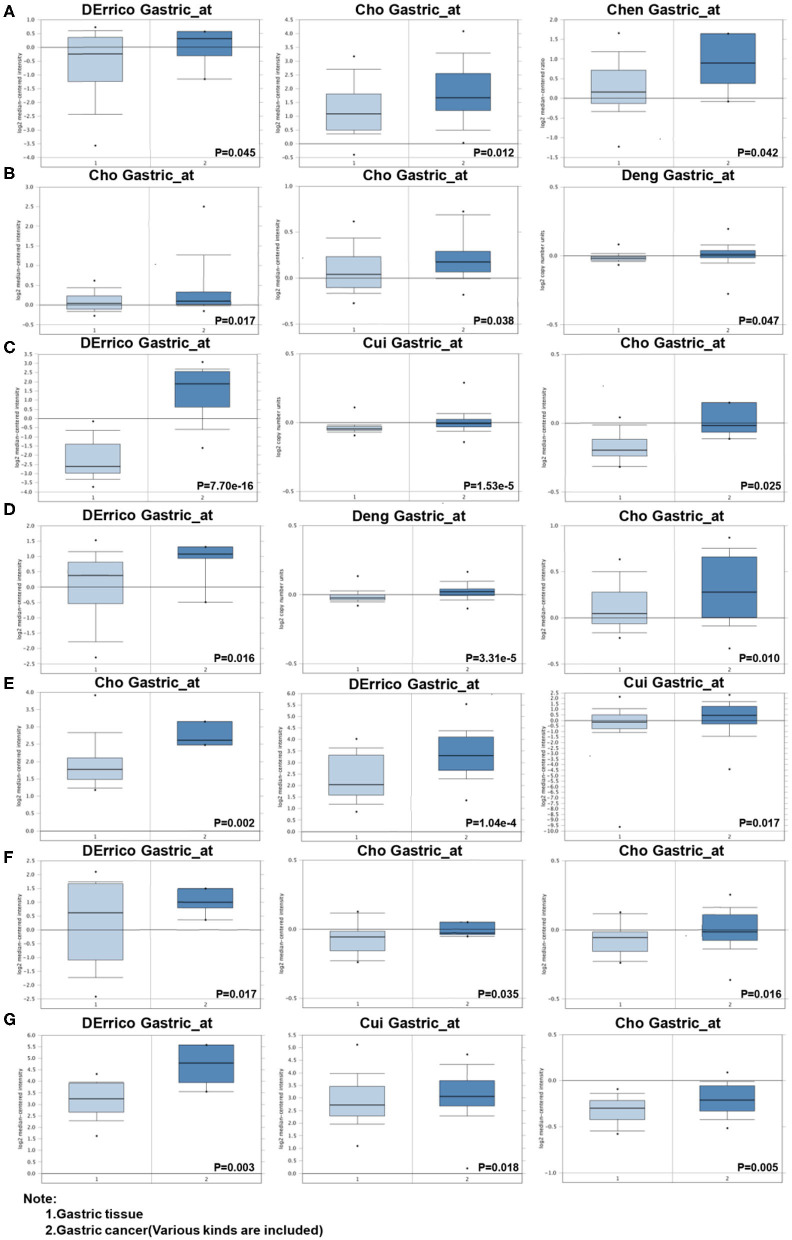
Validation of the expression of seven GRGs at the transcriptional level between normal tissues and GC tissues by the Oncomine database. (A) STC1; (B) CLDN9; (C) EFNA3; (D) ZBTB7A; (E) NT5E; (F) NUP50; (G) CXCR4. P < 0.05 was considered to be statistically significant.